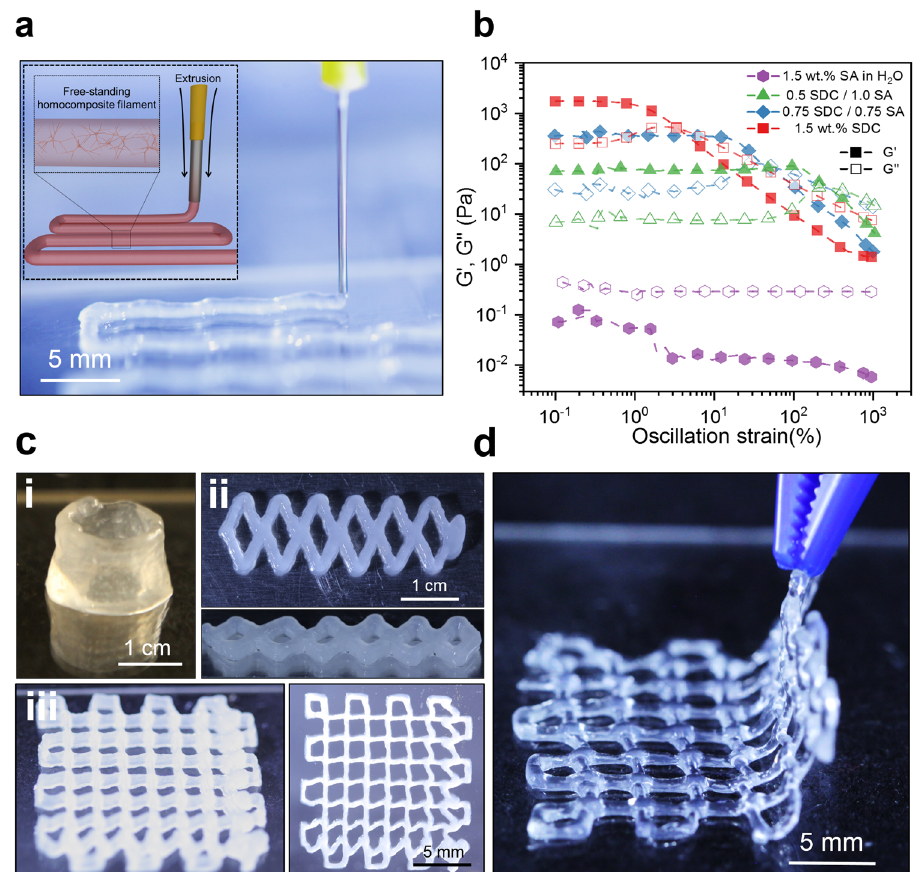
Fig. 5 3D printing with homocomposite hydrogels. a Schematic illustration and image of 3D printing of SA HHG ink. b Complex modulus vs. stress curves for 1.5 total wt.% SA and SDC/SA HHG mixtures containing CaCO 3 nanoparticles, prior to GDL addition measured at 6.23 rad/s. c Images of extruded HHG paste that has been layered in 3D (0.75 wt.% SDC, 0.75 wt.% CMH): (i) 10 layers from a 18 G nozzle, (ii) 3 layers from a 16 G nozzle, (iii) 5 layers from a 25 G nozzle. d Removal of the equilibrated hydrogel design from the substrate. HHG formulations have the ability to fl ow upon extrusion, maintain their shape due to the colloidal yield stress, and result in a strongly self-reinforced structure following completion of the secondary ionic crosslinking